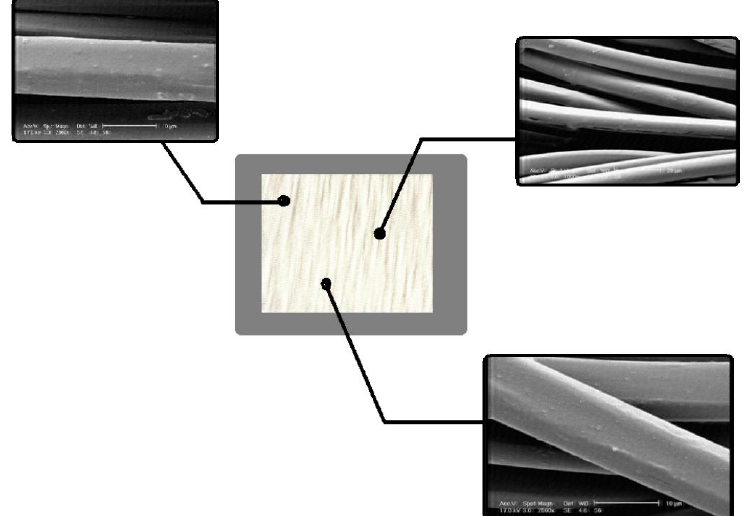
Fig. 3. Photographic and SEM visualized surface morphology of virgin Ingeo™ fibers (1000x and Figure 3: Photographic and SEM visualized surface morphology of virgin Ingeo ™ fibers (1000x and 2500x).